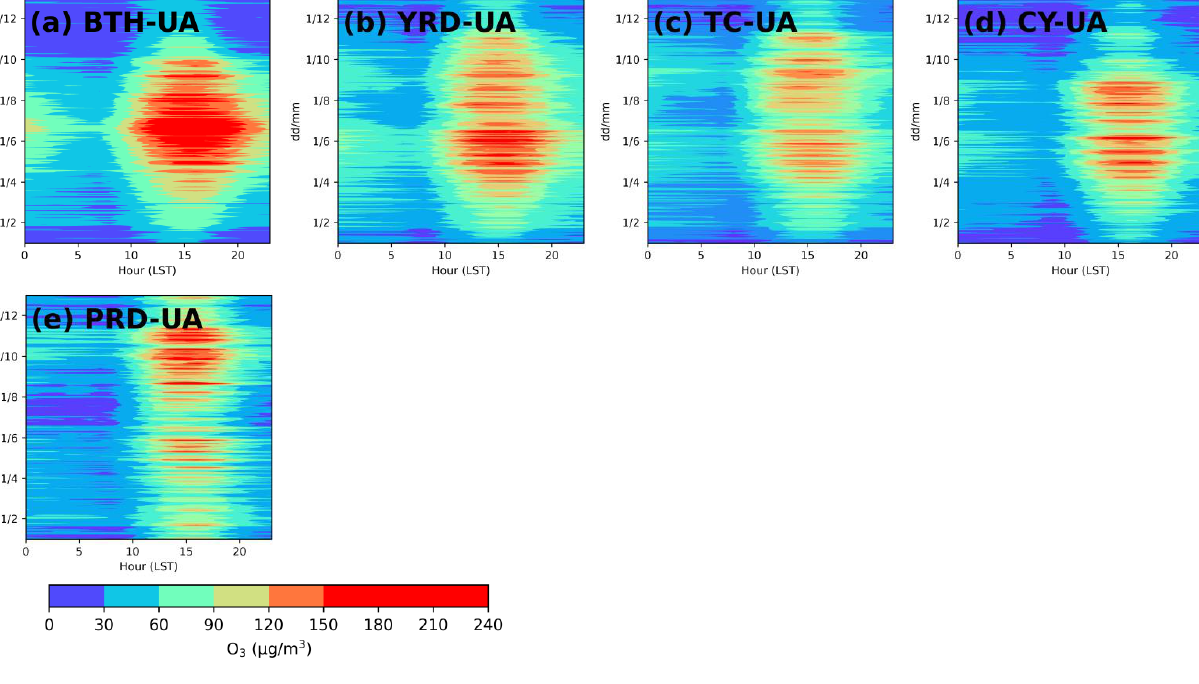
Figure 5. Diurnal variations of O 3 concentrations in ( a ) BTH-UA, ( b ) YRD-UA, ( c ) TC-UA, ( d ) CY-UA, and ( e ) PRD-UA during 2017 – 2020.